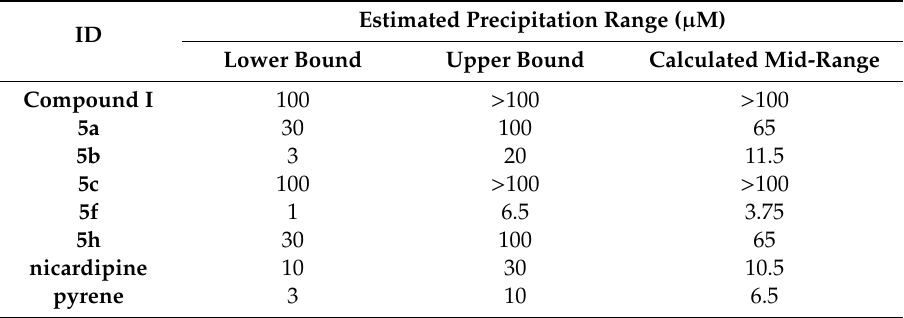
Table 2. In vitro aqueous solubility of diarylethylamine salt analogues ( 5a – 5c, 5f, and 5h ) compared to nicardipine and pyrene (as control compounds) in bu ff ered aqueous solution.